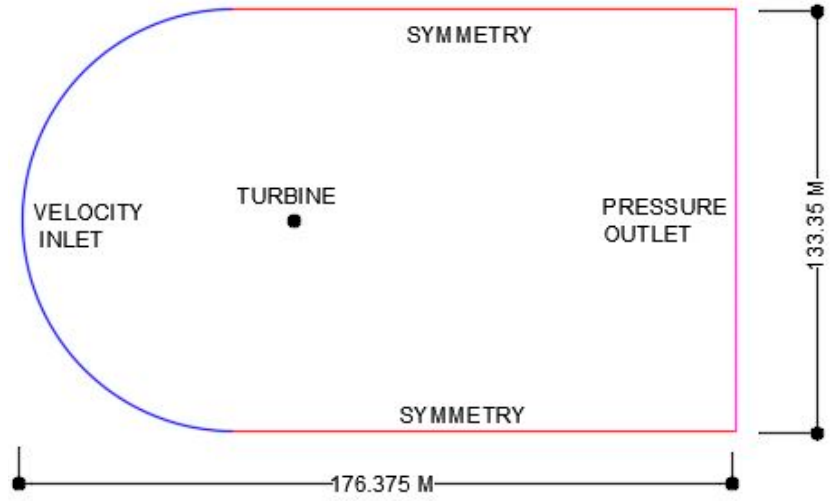
Figure 1. The computational fluid dynamics (CFD) domain for a single turbine.